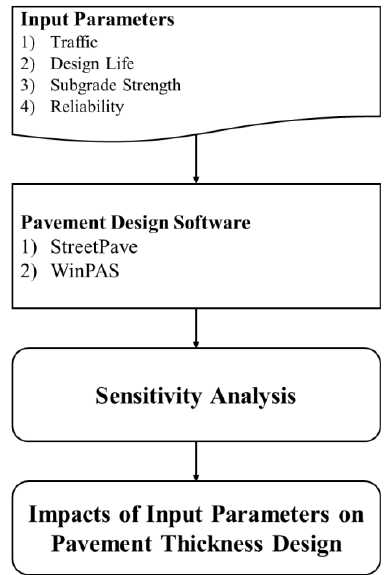
Figure 1. Flowchart of Design Sensitivity Analysis Process. Table 3. Typical average daily truck tra ffi c for five functional